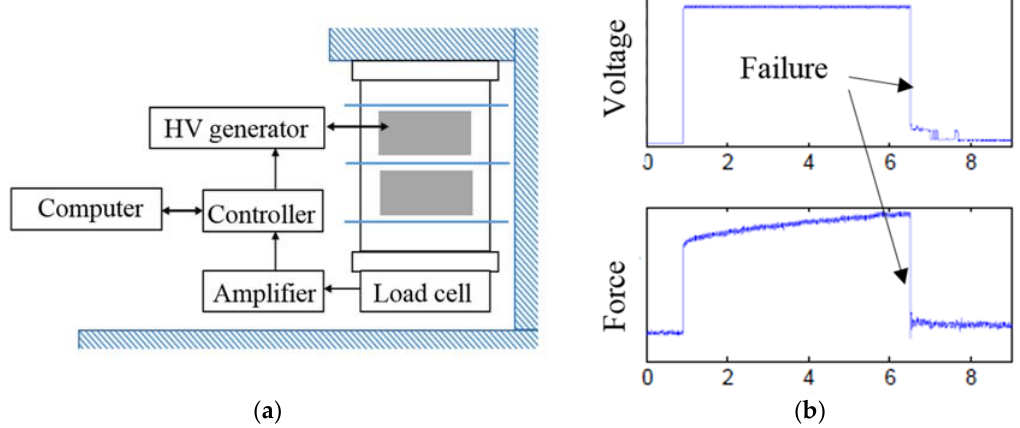
Figure 4. Experimental system: ( a ) test rig set-up; and ( b ) failure detection through voltage monitoring and force measurement.